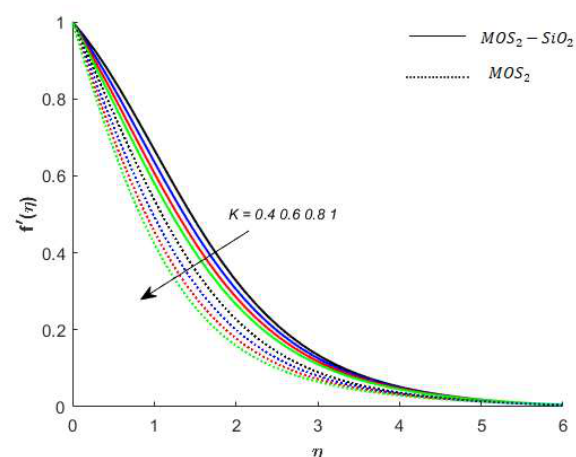
Figure 4. Variation in velocity for (𝐺𝑟) (cid:3047) when 𝑀 = 0.2, 𝑃𝑟 = 2.36,𝐸𝑐 = 0.01,𝑆𝑐 = 0.8,𝑆𝑟 = 0.1,𝐾 = 0.1,𝐵𝑖 = 0.05,and 𝛽 ∗ = 0.1 .